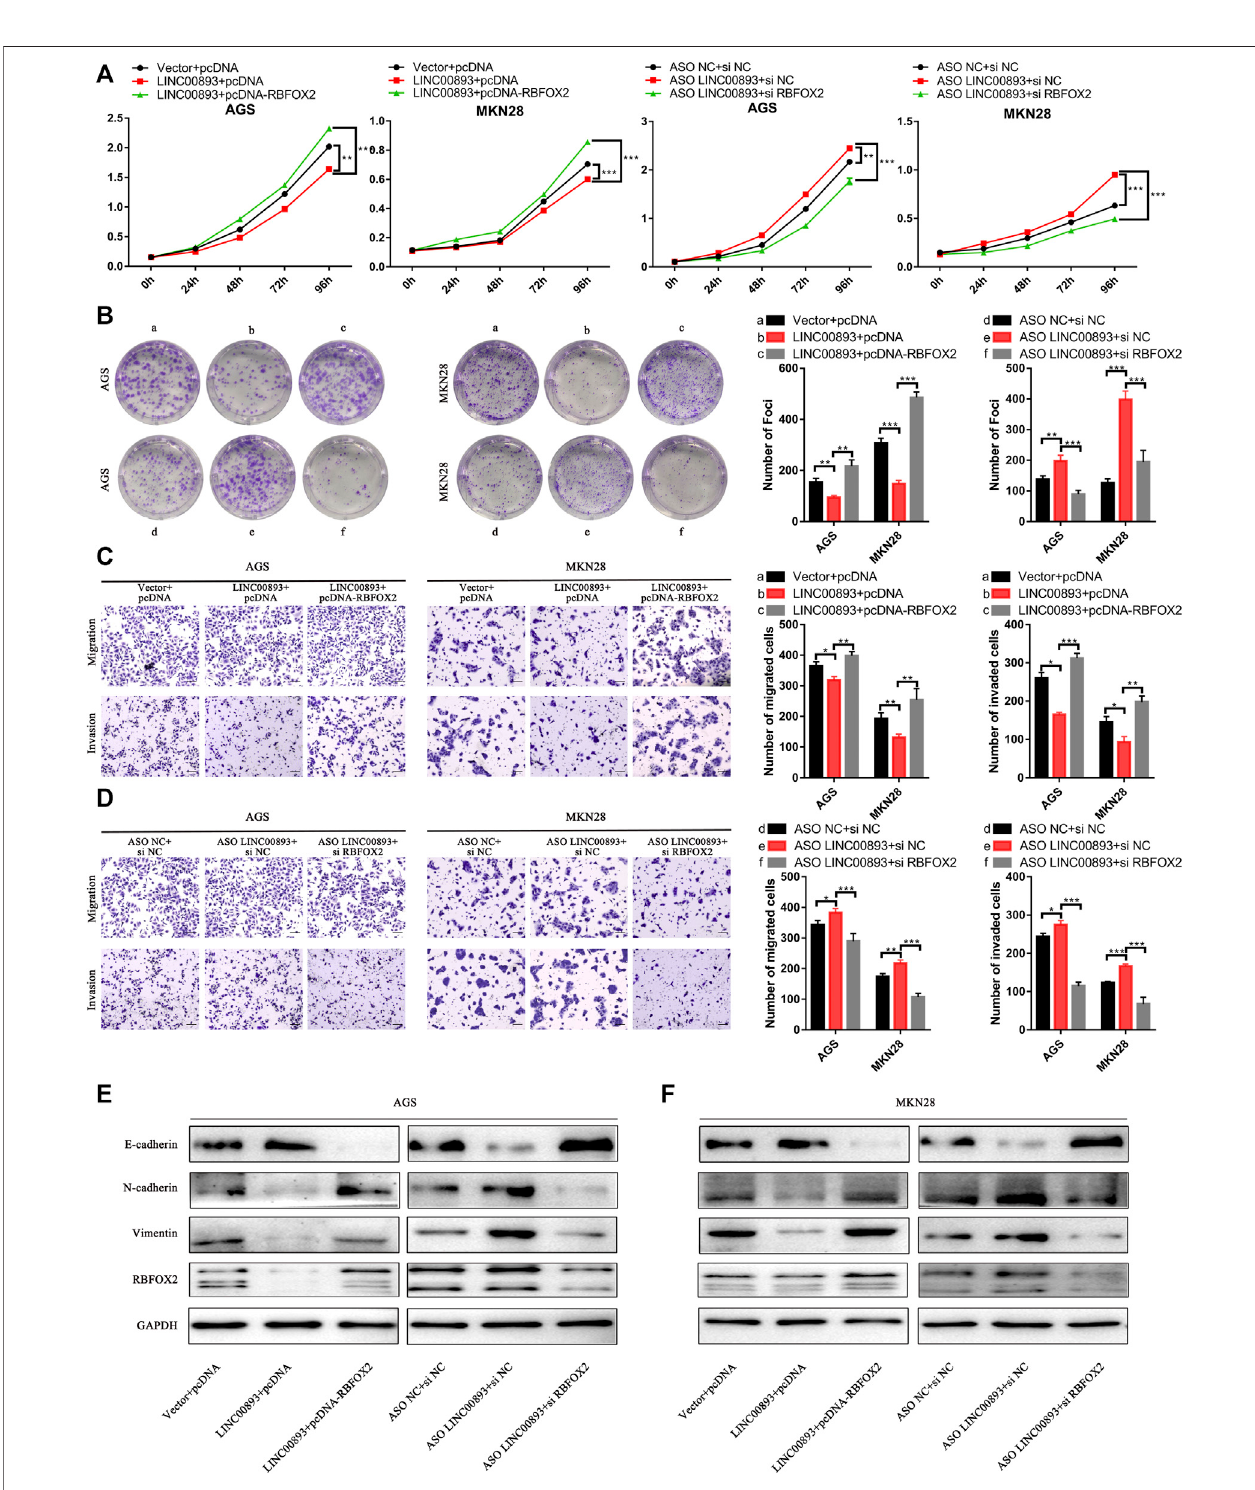
FIGURE 7 | LINC00893 suppresses the proliferation and metastasis of GC cells through RBFOX2 (A,B) The effects of LINC00893 overexpression or knockdown on proliferation and plate colony-forming ability were rescued by RBFOX2 in GC cells (C,D) The effects of LINC00893 overexpression or knockdown on migration and invasion ability were rescued by RBFOX2 in GC cells (E,F) The effects of LINC00893 overexpression or knockdown on E-cadherin, N-cadherin and Vimentin were rescued by RBFOX2 in GC cells.